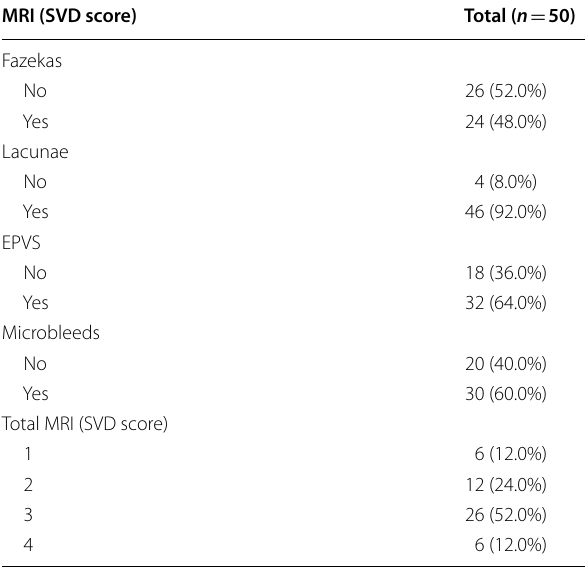
Table 1 MRI SVD score distribution of the study